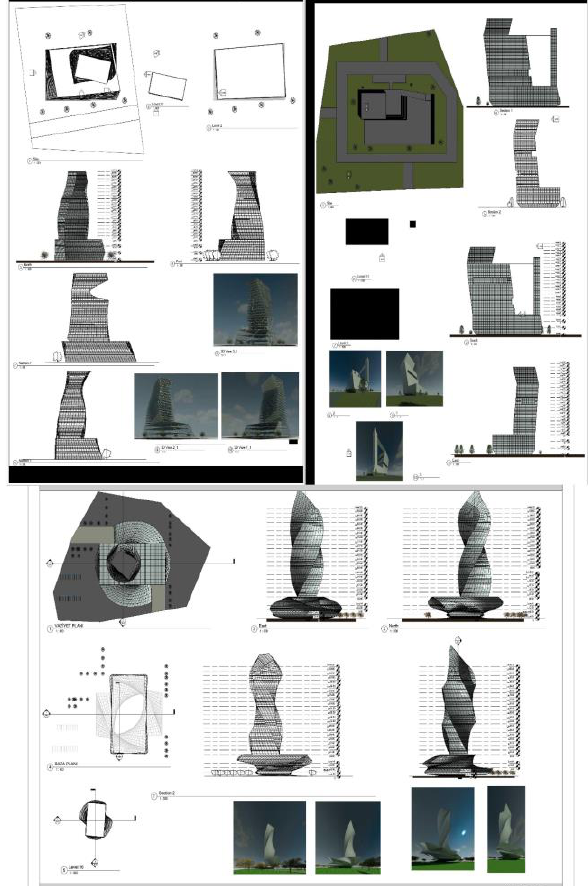
Figure 2: Three of the total 75 5 th semester students’ final exams’ presentations